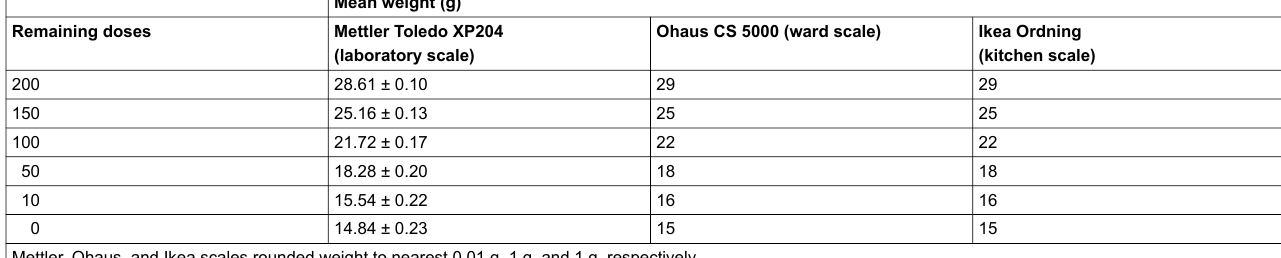
Ikea Ordning (kitchen scale)